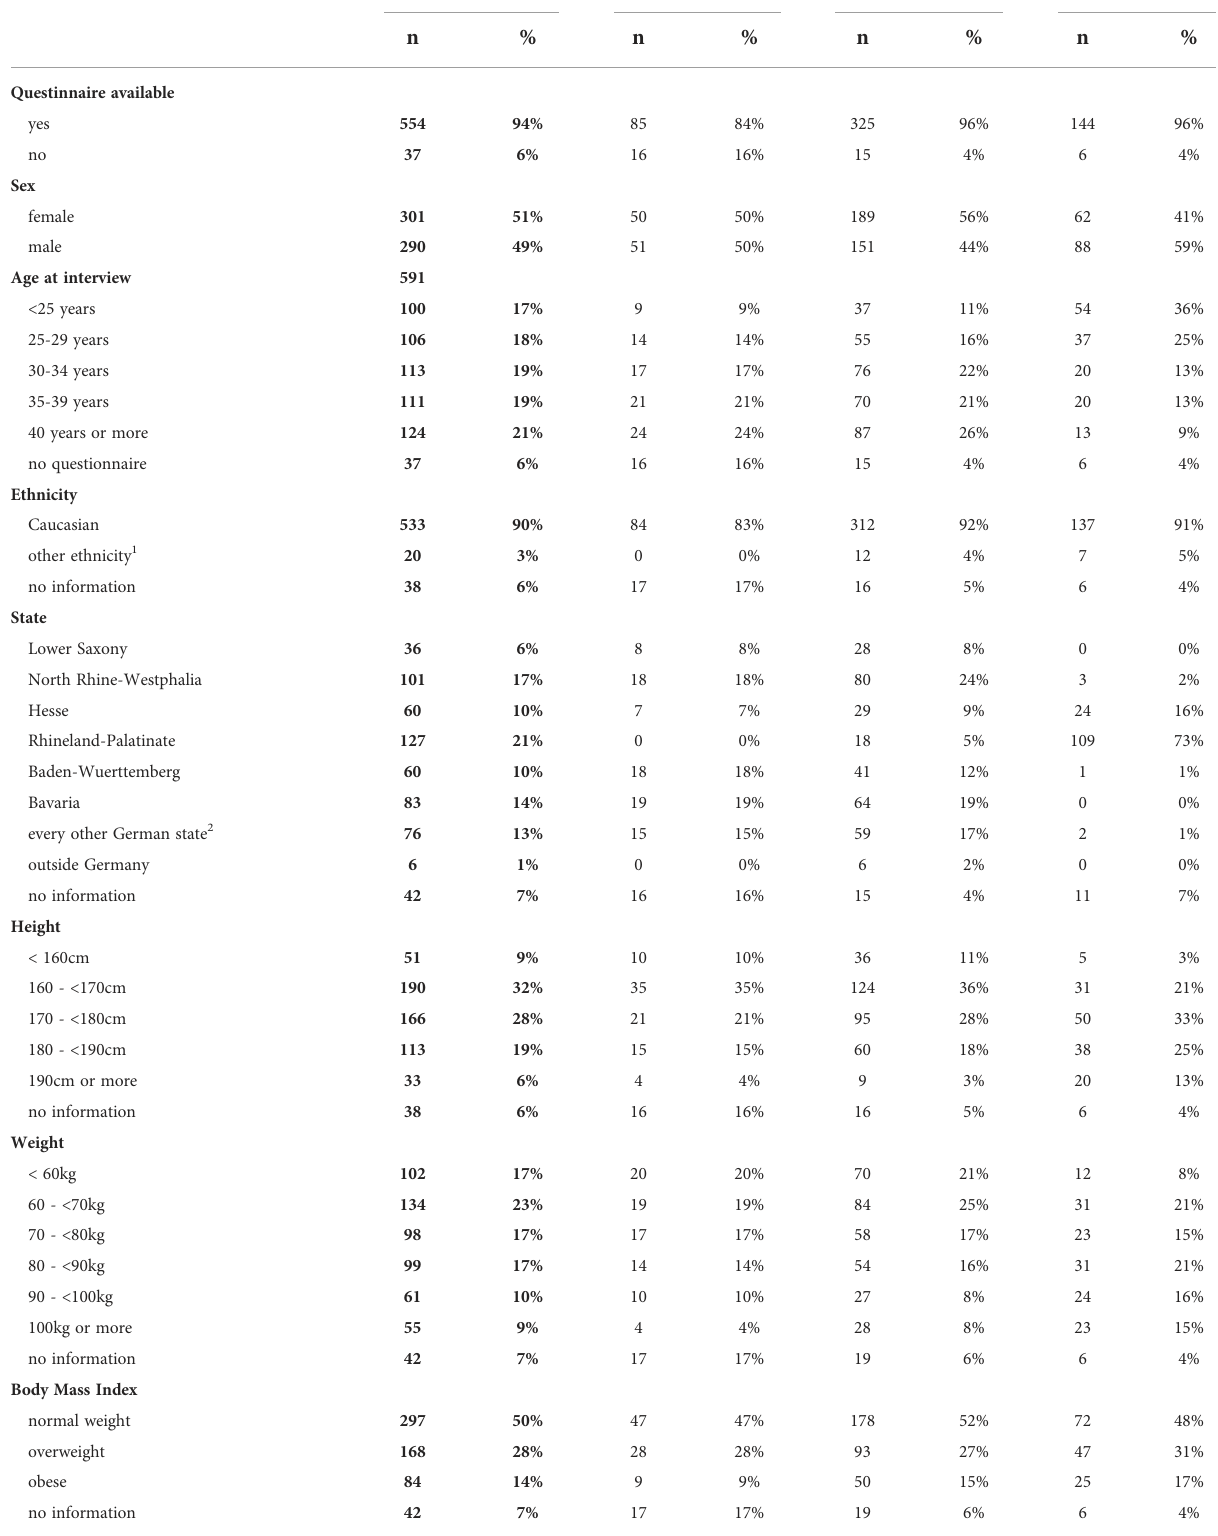
TABLE 1 Distribution of cases (SPN and FPN) and controls (CO) of the KiKme study. Total